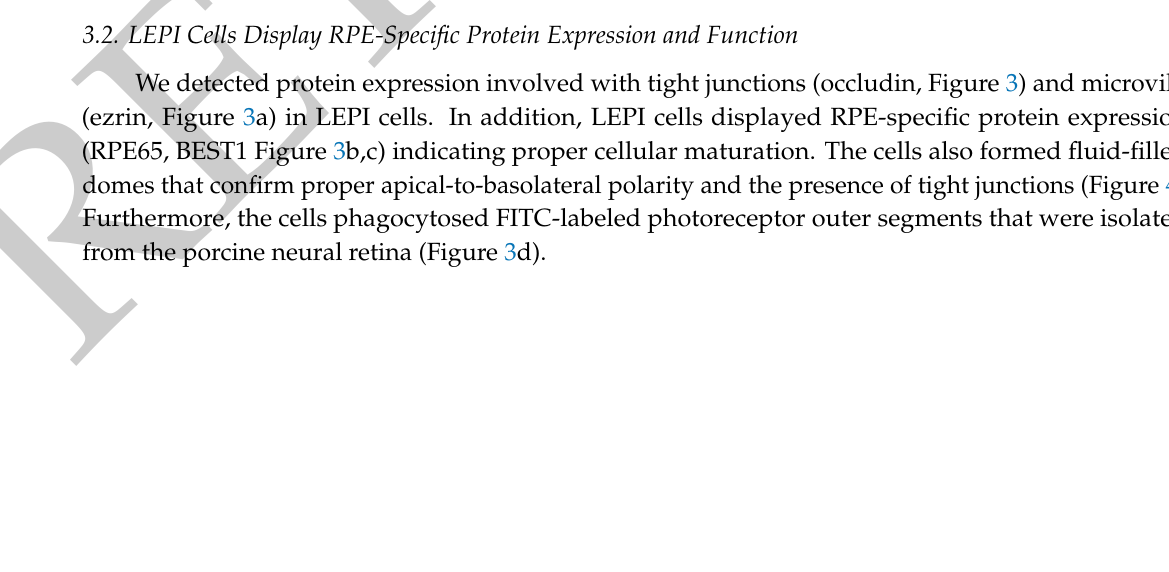
Figure 2. LEPI cells form similar tight junctions and microvilli with primary RPE cells. SEM imaging was used to evaluate the microvilli formation ( a , c , e ). ARPE19 cells ( a ) do not form clear microvilli, whereas hfRPE cells ( c ) and LEPI cells ( e ) display microvilli. Scale bars of SEM images ( a , c , e ) are 200 nm. The TEM images show tight junctions (circled) in ARPE19 ( b ), hfRPE ( d ) and LEPI cells ( f ). ARPE19 TEM image scale bar is 2 µ m ( b ), and the LEPI ( f ) and hfRPE ( d ) image scale bars are 500